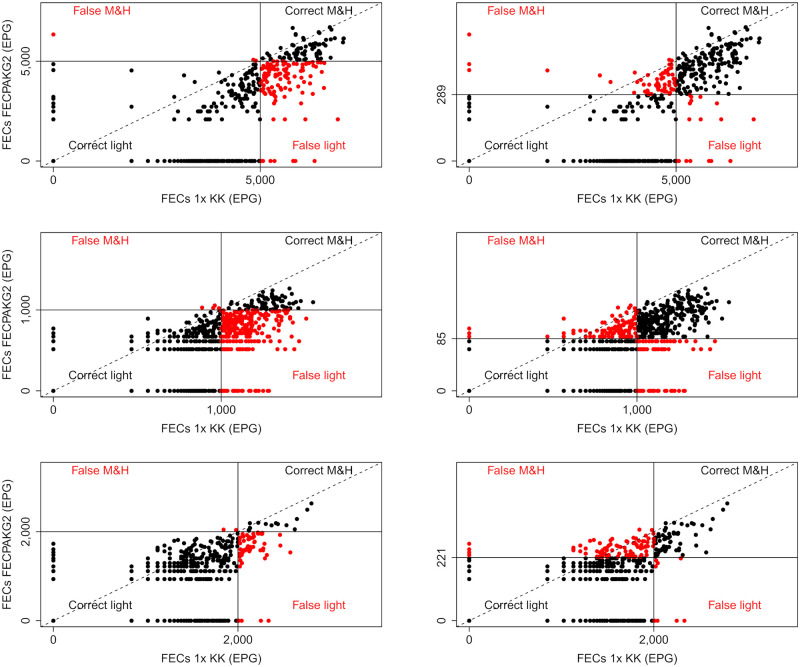
Agreement in classifying infection intensities for FECPAKG2 when applying WHO and method-specific thresholds.The scatter plots represent the degree of agreement between FECPAKG2 and a single Kato-Katz (1x KK; reference method) in classifying infection intensity based on World Health Organization (WHO; Table 1) or the method-specific thresholds (Table 4) for Ascaris, Trichuris and hookworms. The full black dots indicate that intensity of infection was correctly classified as light (bottom left quadrant) and moderate-to-heavy (M&H; top right quadrant). The red dots indicate that intensity of infection was falsely classified as light (bottom right quadrant) and M&H (top left quadrant). The full lines represent the thresholds, the dashed line represents the line of equality.